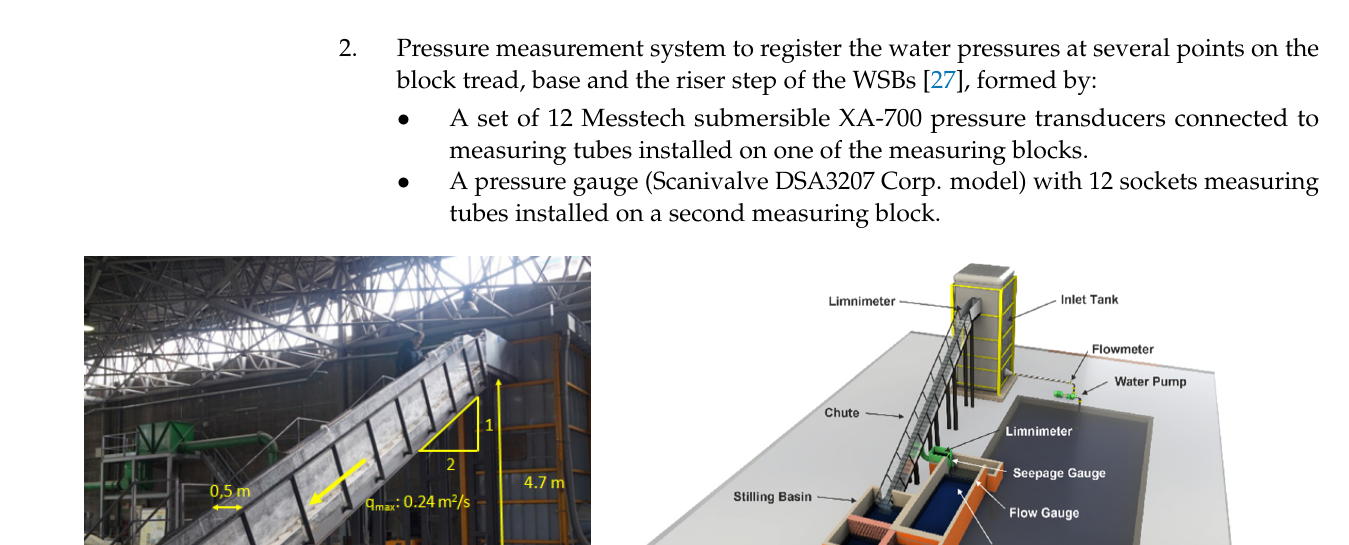
one to obtain 30 items of data per second and channel, and an Ethernet connection system by Scanivalve DSA3207 Corp., which allows one to obtain 70 items of data per second and channel. Furthermore, a conventional video camera was used for recording the tests. 2.2. Flow Test Characterization 2.2.1. Flow Regimes The type of flow regime (nappe, transition or skimming) determines the pressure pat- tern of the stepped chutes. For example, with a transition flow, the suction on the base of the block is lower than with skimming flow [18]. Several authors [2,13,18] relate the slope of the pseudo-bottom (i.e., the straight line connecting the step edges) to the ratio between the flume critical depth ( h c ) and the height of the block riser ( h s ), h ’ (Figure 5, Table 1). Some of them [18] were used here to predict the flow regimes for each tested unit discharge ( q ). In order to compare results with other authors, dimensionless distances were used; l is the distance measured from the upstream end of the exposed tread (position of the pres- sure measurements on each sensor), and l s is the total exposed length of the upper surface of the block. At the base of the block, l ’ is the distance measured from the upstream end of the base (position of the pressure measurements on each sensor), and l ’ b is the total length of the base of the block. The tread length ( l ) refers to the unit length ( l s ) (Figure 5) to obtain the dimensionless parameter ( l l s − 1 ). Figure 5. The geometric parameters of the block. Table 1. Values of h ’ and q used in the tests. h ’ ( h c h s − 1 )